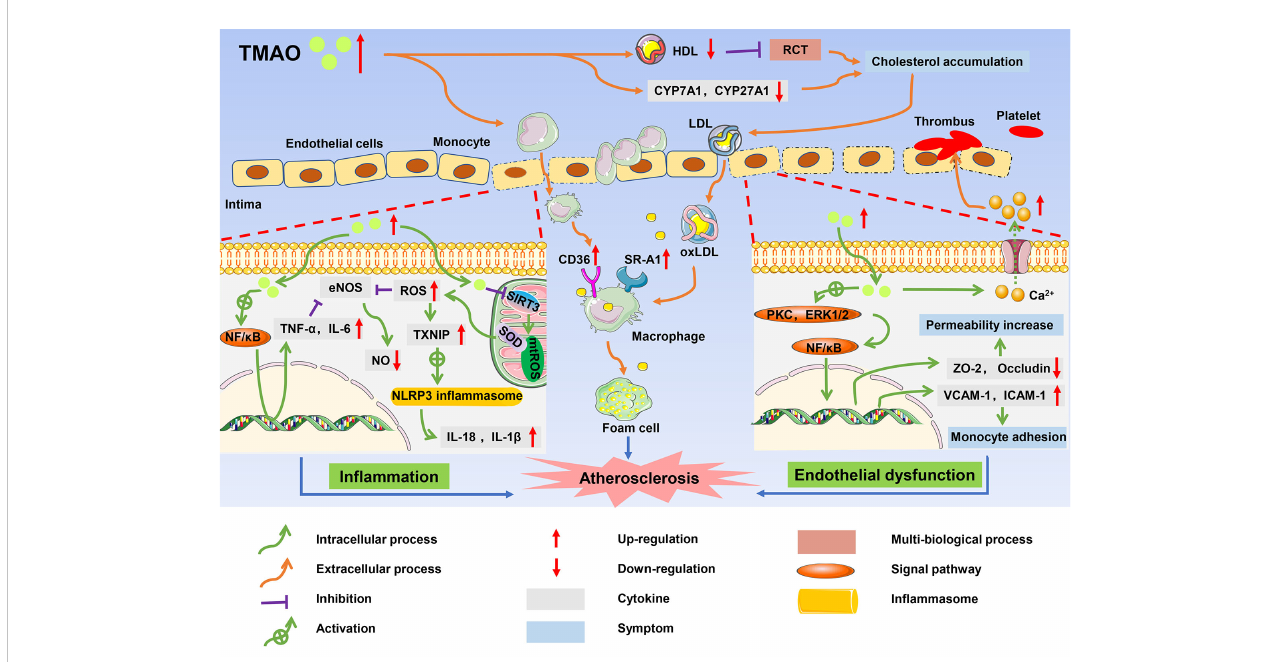
FIGURE 3 The role of TMAO in onset and progression of atherosclerosis. High circulating levels of TMAO inhibited RCT, and accumulated cholesterol, which promoted the formation of foam cells; TMAO induced in fl ammatory responses, resulting in increased production of pro-in fl ammatory cytokines such as TNF- a and IL-1B; TMAO caused endothelial dysfunction and platelet activation, and ultimately contributed to the development of